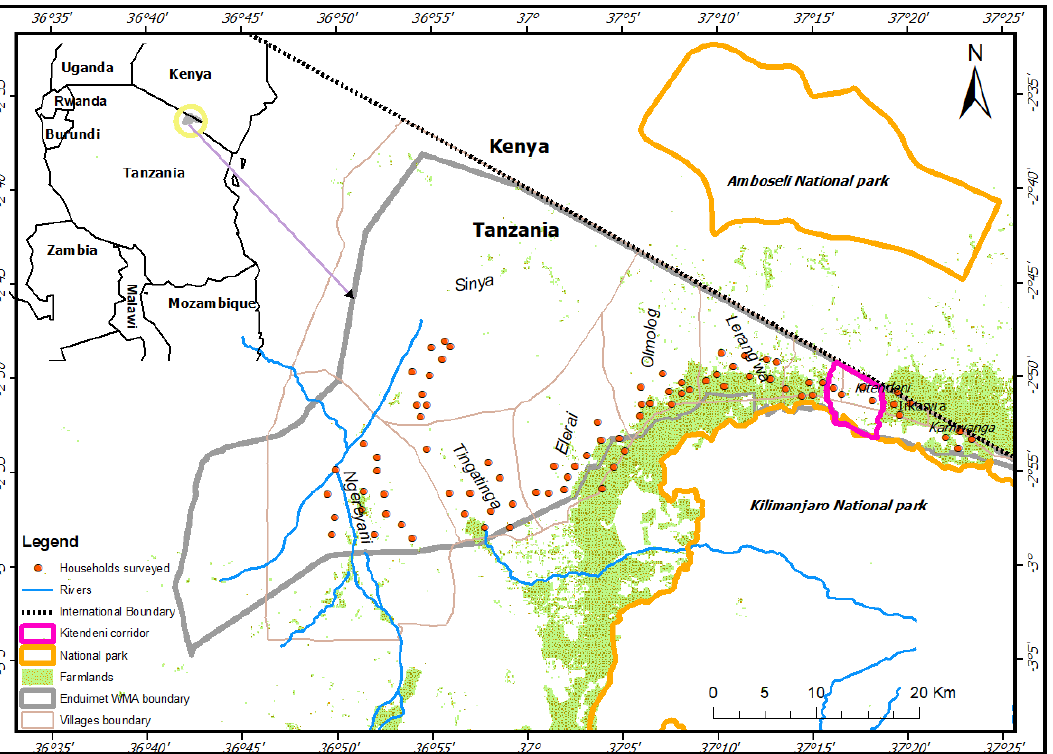
Figure 1. Map of the study area showing the location of households surveyed ( n = 96) across different villages from March 2019 to June 2019 as well as the Kilimanjaro and Amboseli National Parks, Enduimet Wildlife Management Area (EWMA) and farmlands within the EWMA, Tanzania, based on the map of 2019.